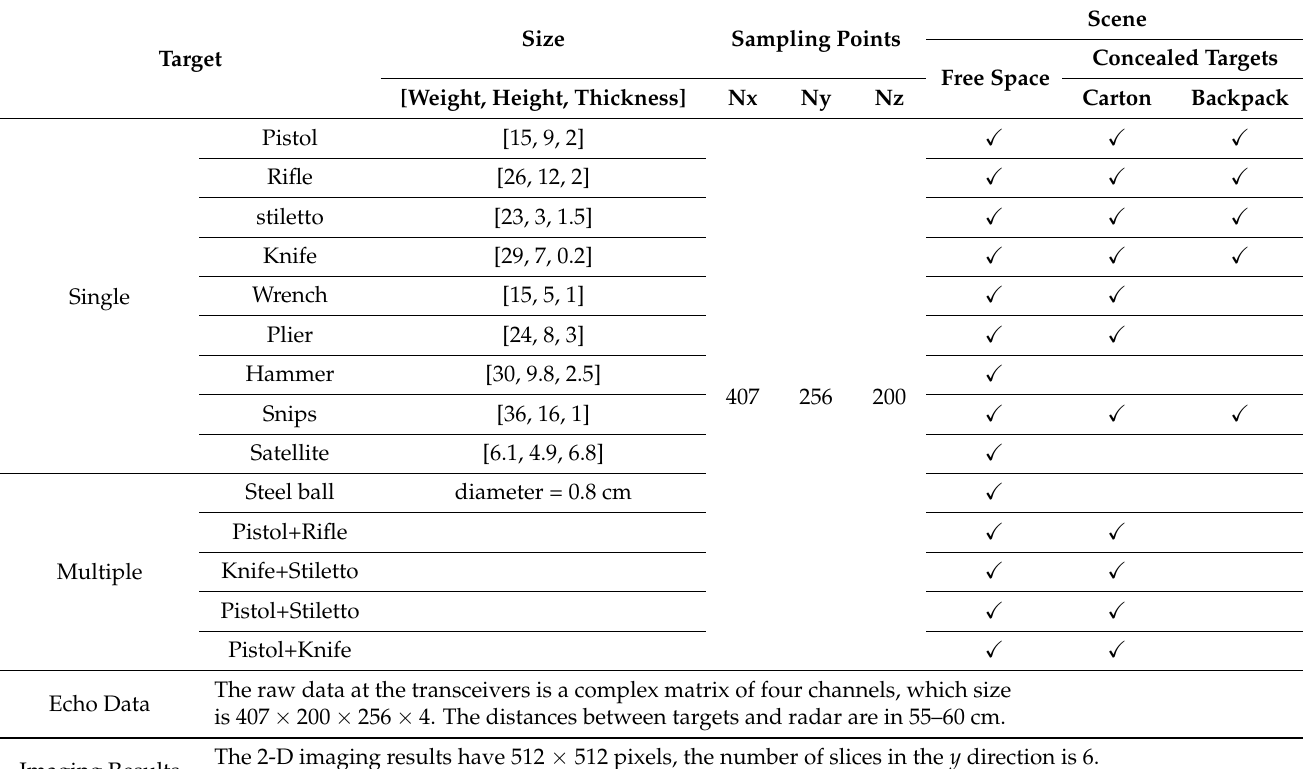
Table 2. Description of the